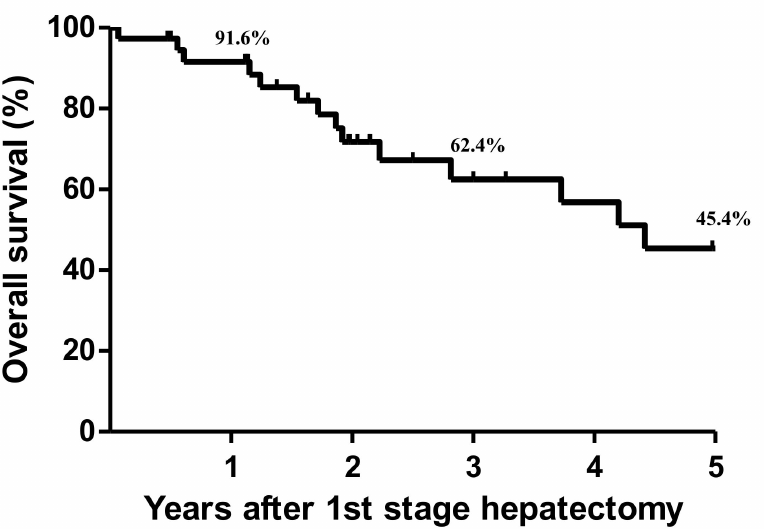
Figure 2. Kaplan–Meier cumulative survival curve for all patients ( n =